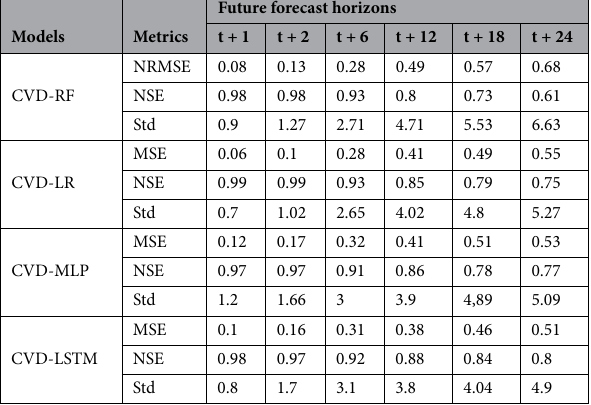
Table 4. Comparison of using CVD with different forecasting models.